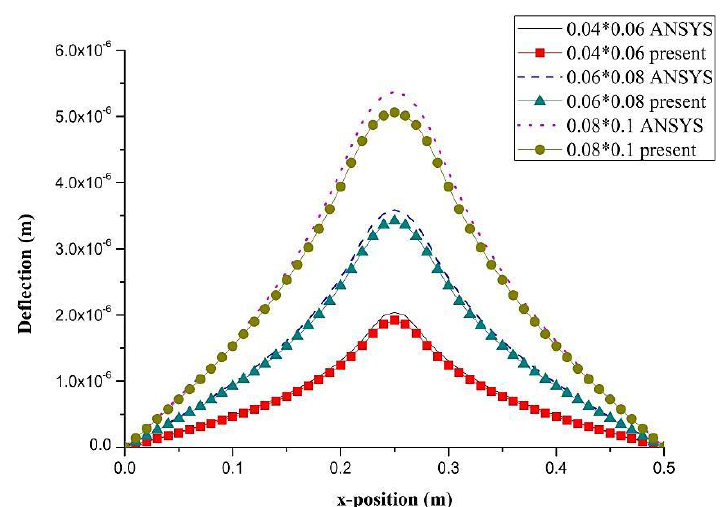
Figure 5. Finite element mesh.